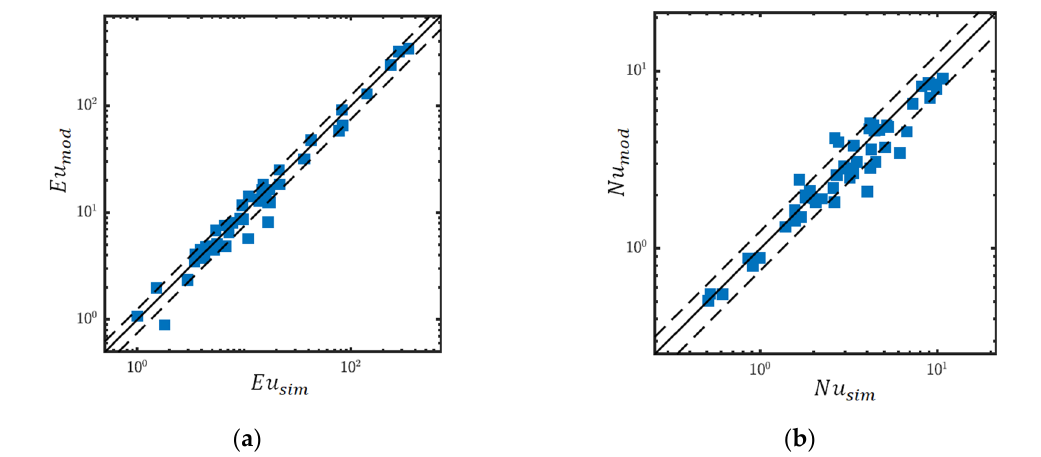
Figure 10. Comparison between results for Euler number Eu g ( a ) and Nusselt number Nu g ( b ) obtained from CFD simulations ( x -axis) and fitted models ( y -axis). Legend: analysis point of parametric study, — parity, - - - - ± 25% deviation.